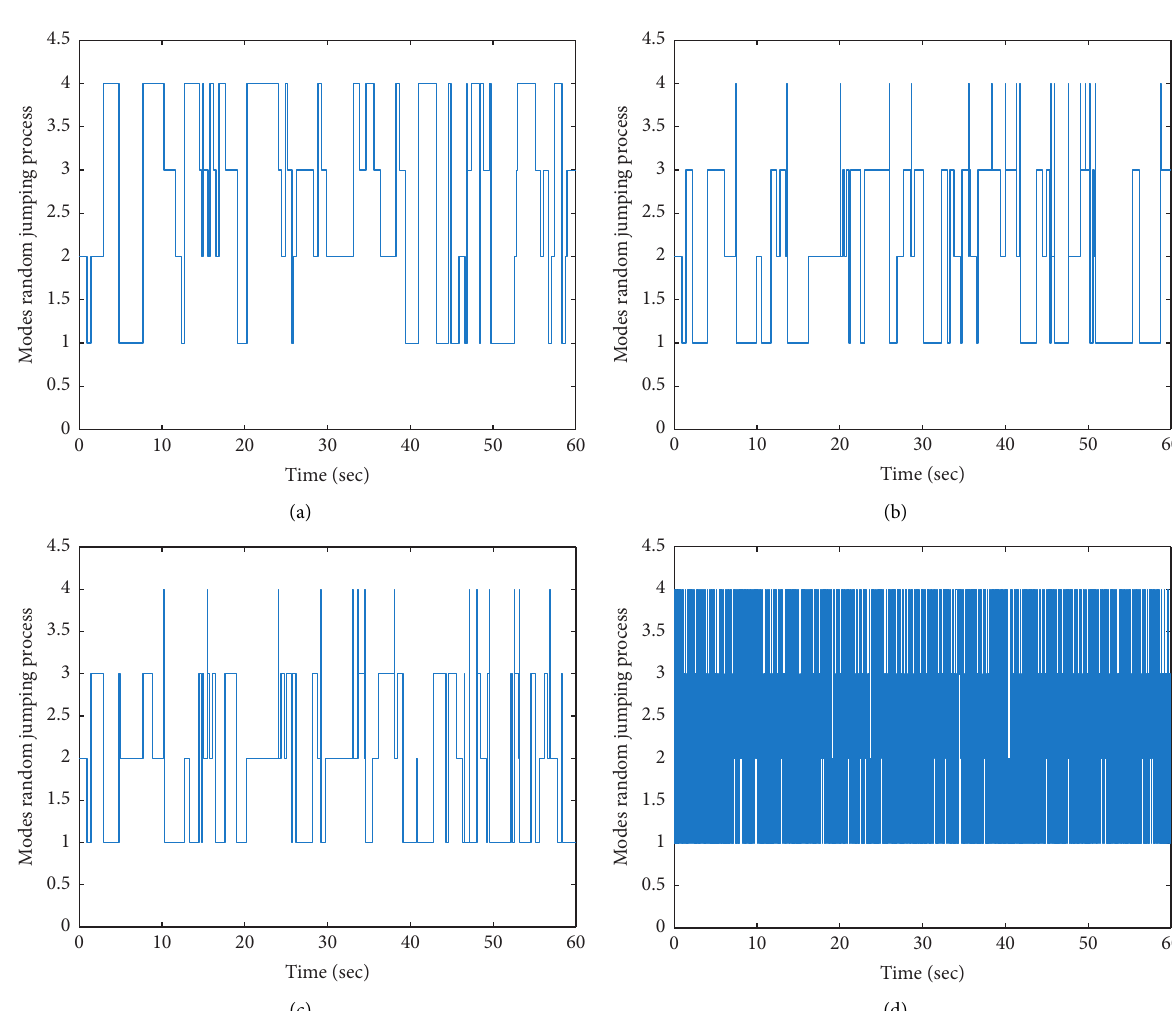
Figure 1: The modes random jumping process of four different TRMs cases. (a) Case 1. TRM is completely known. (b) Case 1. TRM is polytopic uncertain. (c) TRM is partly unknown. (d) TRM is completely